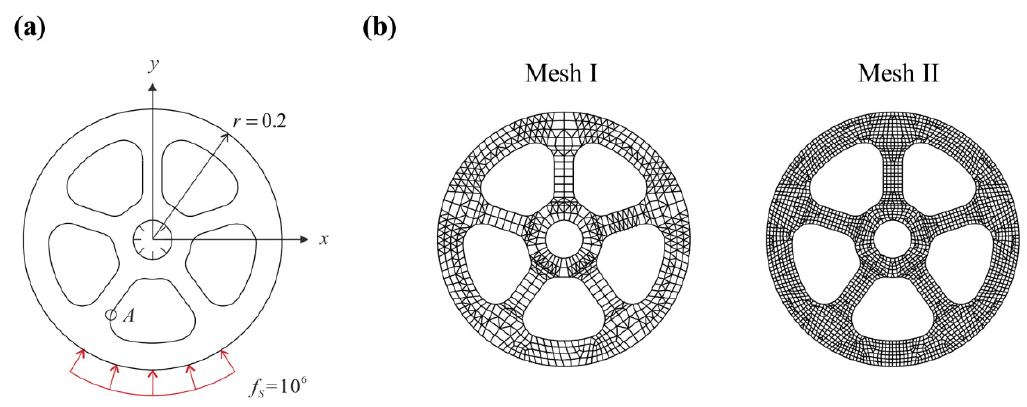
Figure 11. Automotive wheel problem: ( a ) Problem description. ( b ) Sequence of meshes (Mesh I, II, and III) used.